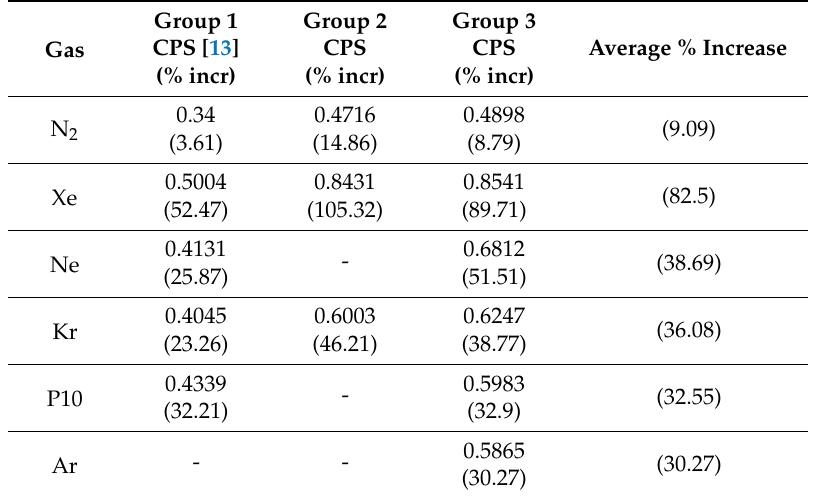
Figure 5. Showing the increase in cps for the different gas flows as a percentage of the air atmosphere results. Table 2. Table of gas flow